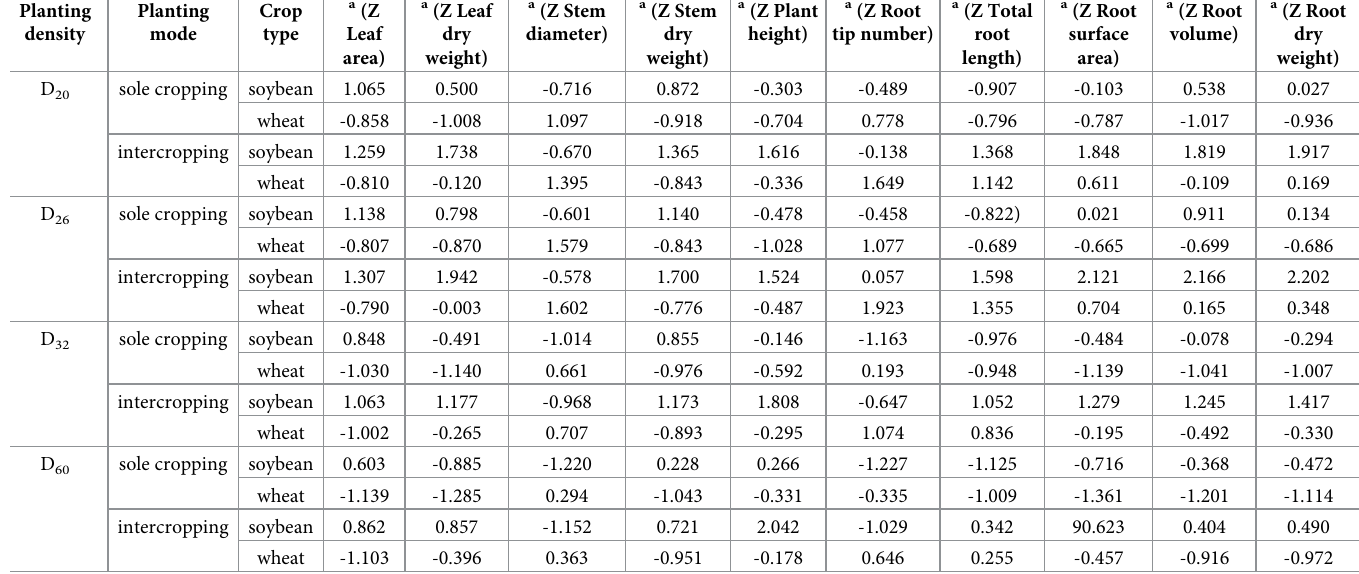
Table 2. Standardized data for population modules in soybean/wheat sole cropping and intercropping populations at low nutrient level and different planting densities. Planting